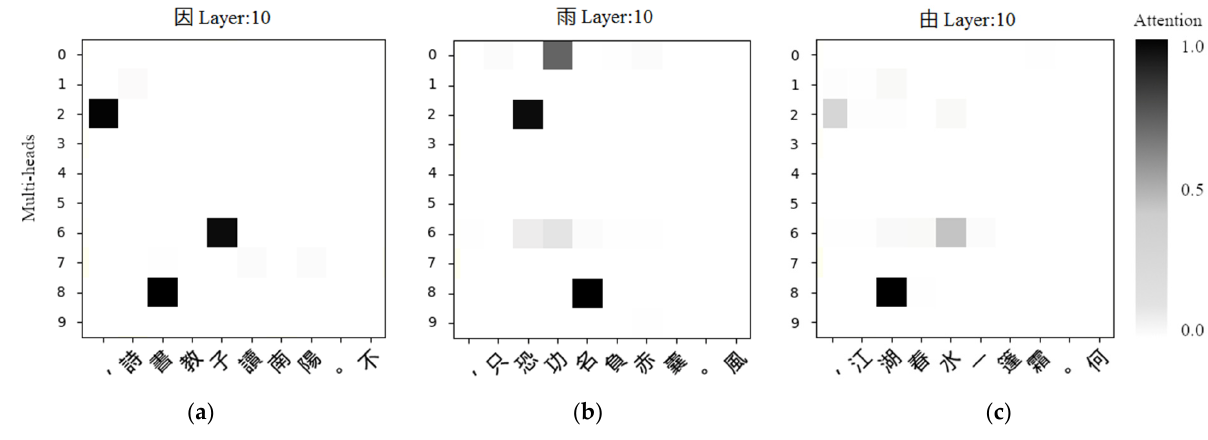
Figure 9. Visualization of the alike-rule. ( a ) reason ( 因 ); ( b ) rain ( 雨 ); ( c ) not ( 由 ). For the rhyming-rule, the last characters in the even lines i.e., sun ( 陽 , yang), bag ( 囊 , nang), frost ( 霜 , shuang), and monarch ( 王 , wang) have the same rhyming and are all Ping-